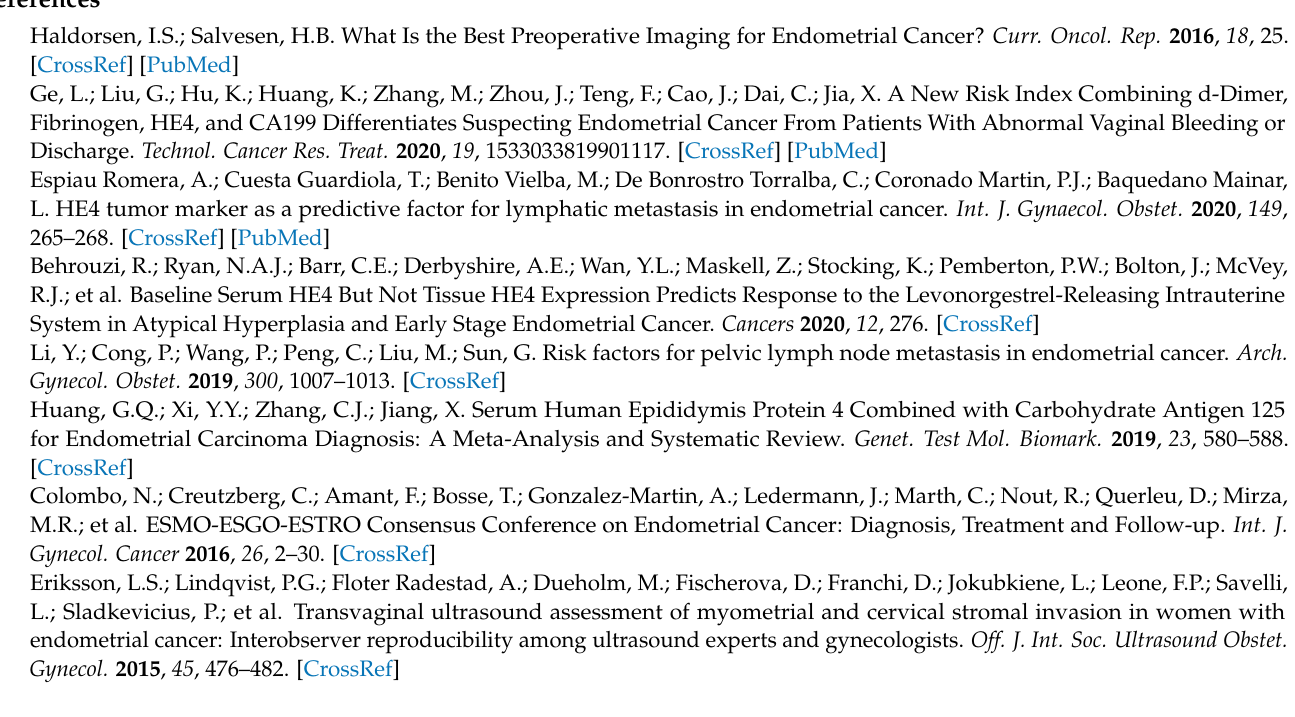
malignant signs and tumor biomarkers. Table S2: The ROC curve analysis values of each diagnostic method. Table S3: The results of traditional ultrasound GI-RADS classification for uterine or endome- trial lesions combined with serum tumor biomarkers. Table S4: The results of modified ultrasound GI-RADS classification for uterine or endometrial lesions combined with serum tumor biomarkers. Table S5: Comparison of pathological results of different GI-RADS